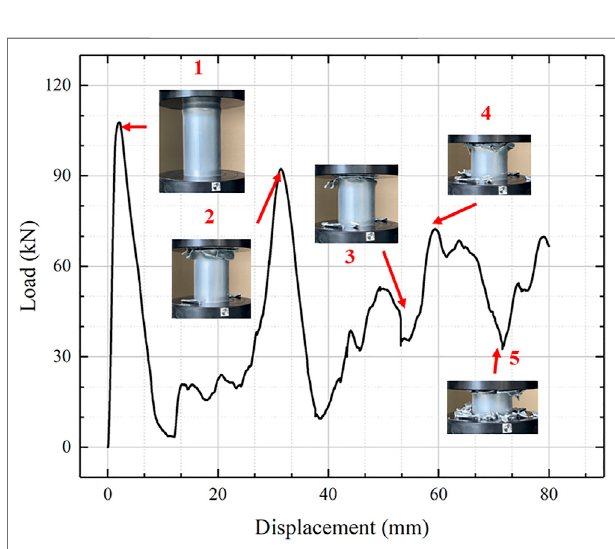
FIGURE 3 | Load – displacement curve with deformation modes of the AL